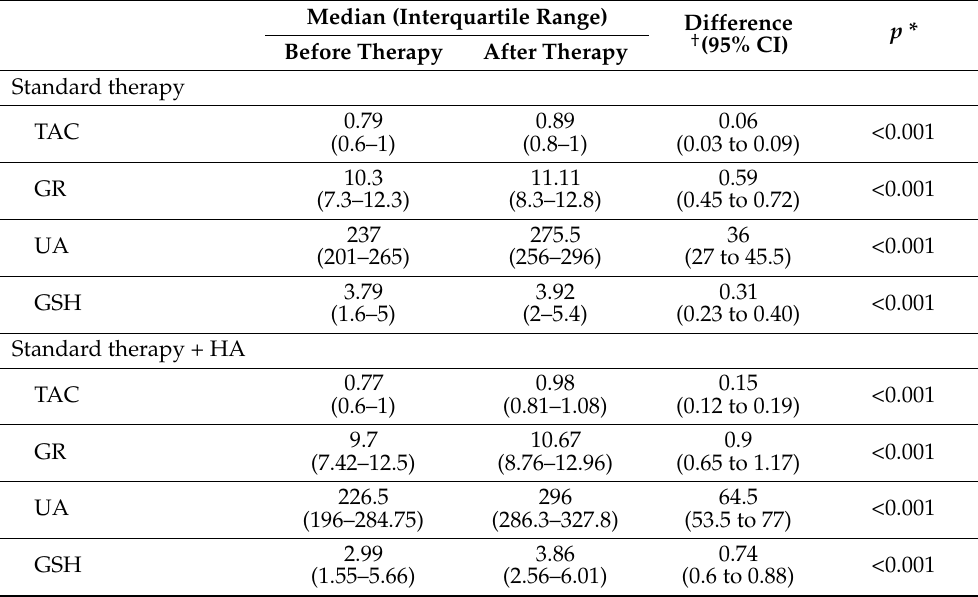
Table 2. Values of observed parameters before and after therapy within every group.